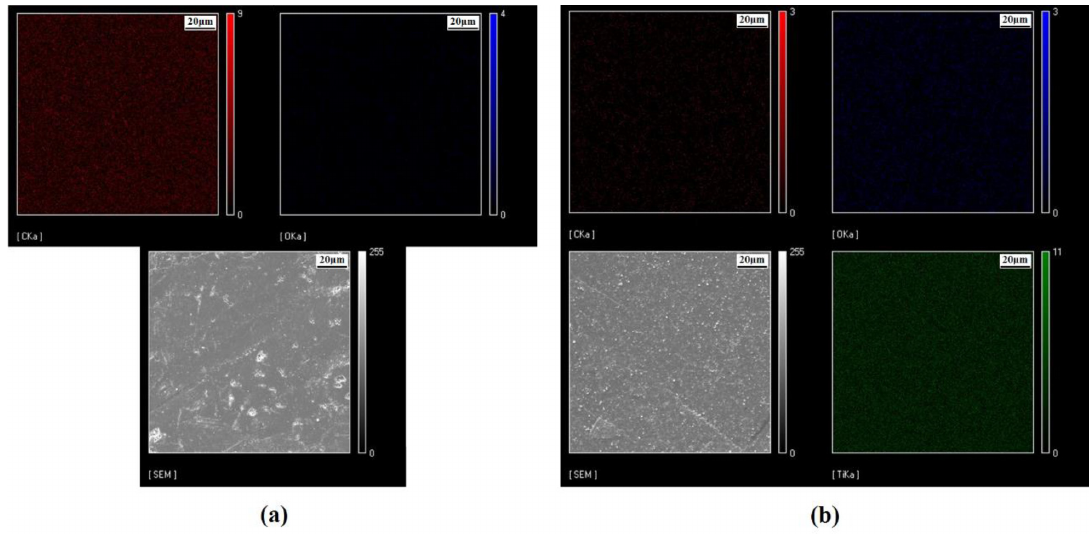
Figure 5. Mapping by EDS for (a) uncoated diamonds and for (b) Ti-coated diamonds, prior to heat